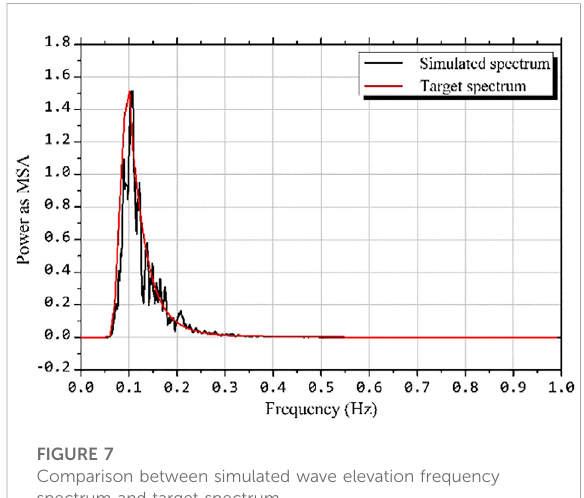
FIGURE 7 Comparison between simulated wave elevation frequency spectrum and target